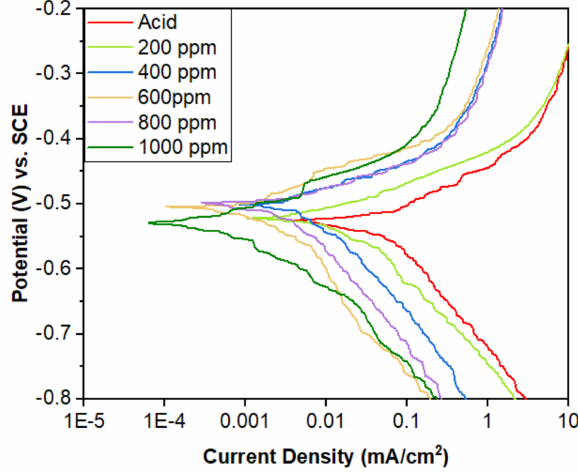
Figure 16. Potentiodynamic polarization curves for the mild steel in the 1 M H 2 SO 4 containing different concentrations of inhibitors in as-immersed conditions.